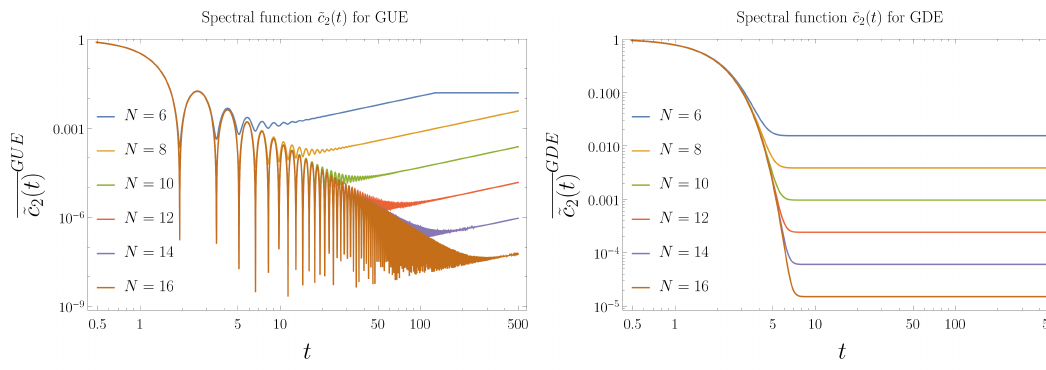
( t ) = c ( t ) / d 2 averaged over the GDE 2 2